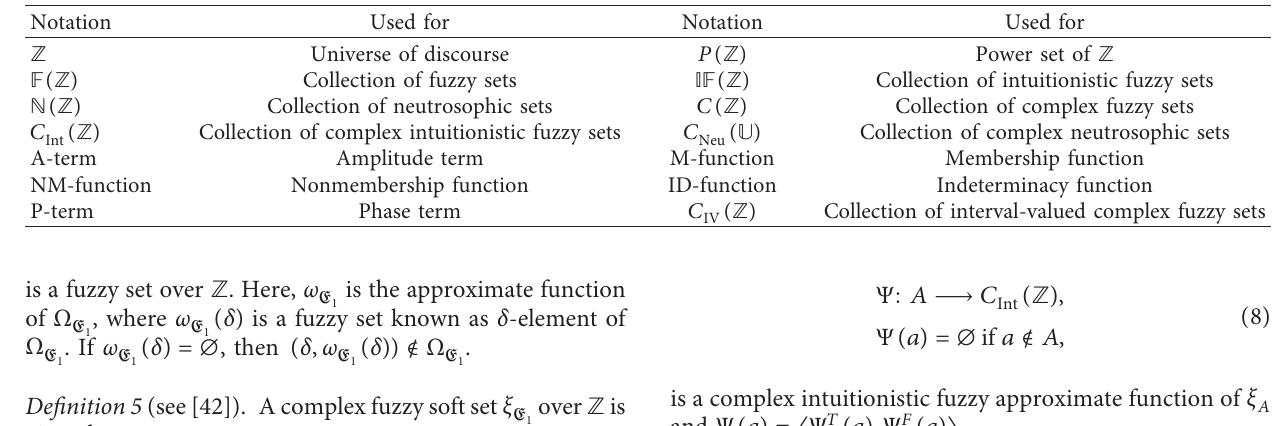
Figure 2: Organization of paper. Table 2: Notations and